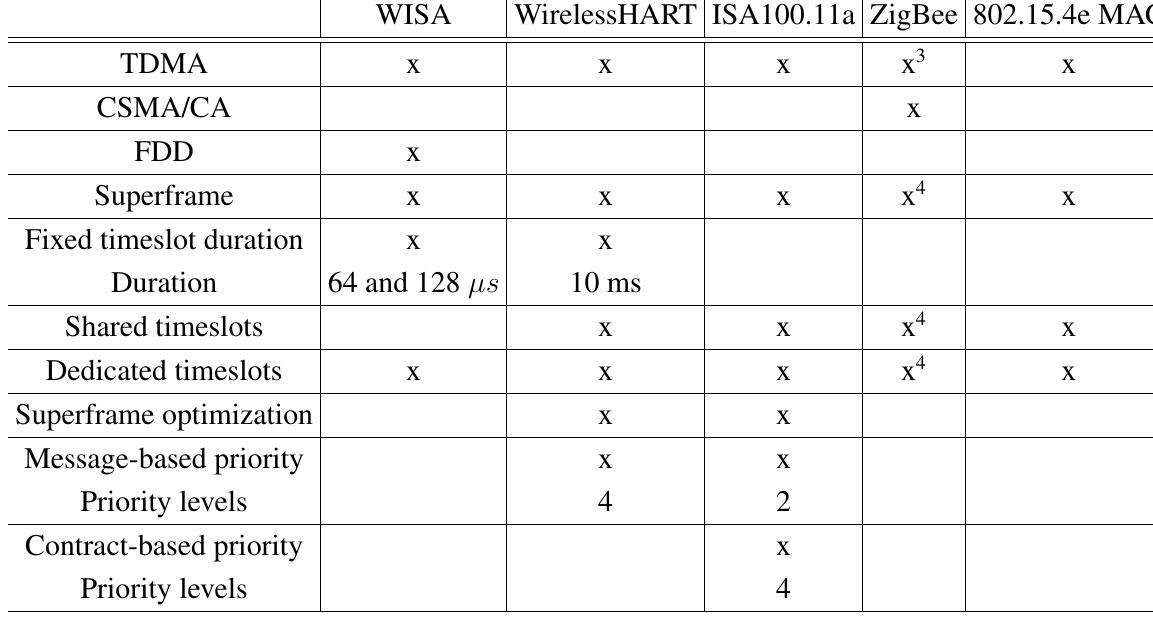
Table 3. Features relevant for real-time